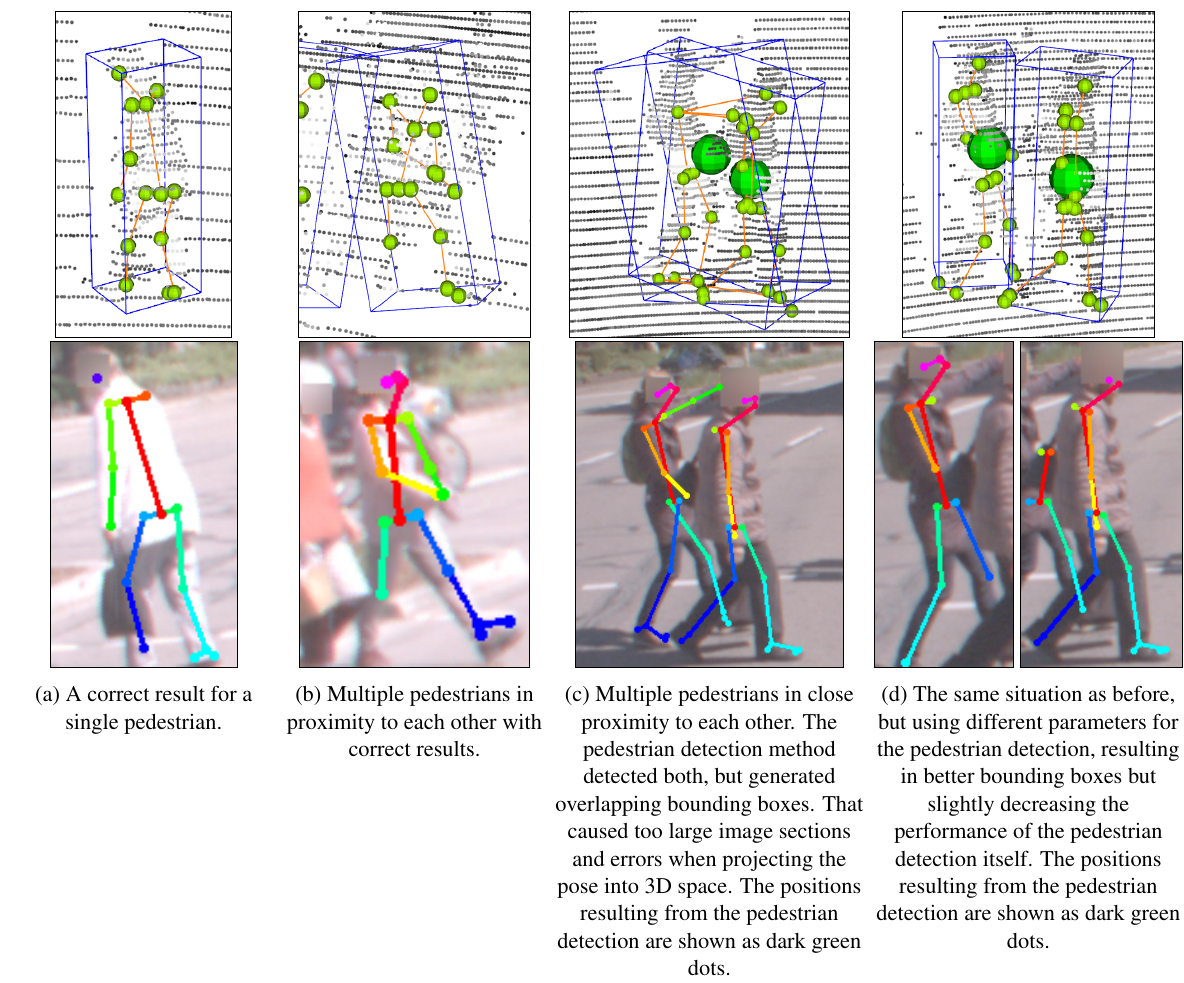
Figure 4. Exemplary results. Pedestrians detected in a 3D point cloud with bounding box and generated image sections superimposed with body pose estimation results. Body pose keypoints have been projected back into the point cloud (light green